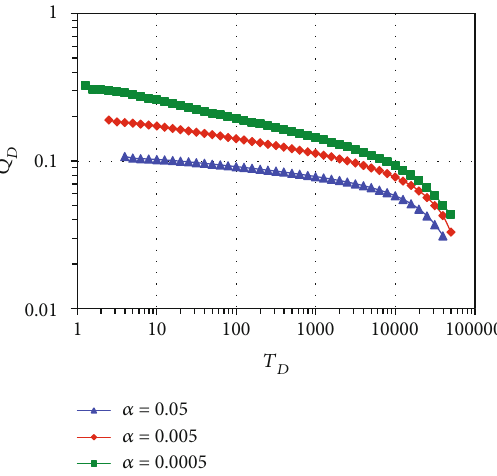
Figure 13: Dimensionless productivity curve considering the in fl uence of di ff erent threshold pressure gradients and stress